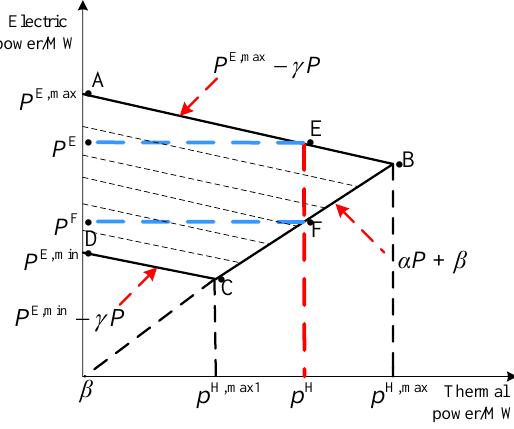
where P E,max and P E,min represent the maximum and minimum outputs of the unit under pure condensing conditions, respectively, MW; α represents the coefficient of elasticity of the thermal power unit; γ represents the reduction in the amount of electricity generated under the condition that the amount of air intake is constant and the unit of heat is extracted; β is a constant; P H,max indicates the maximum heat supply that the unit can provide, MW.